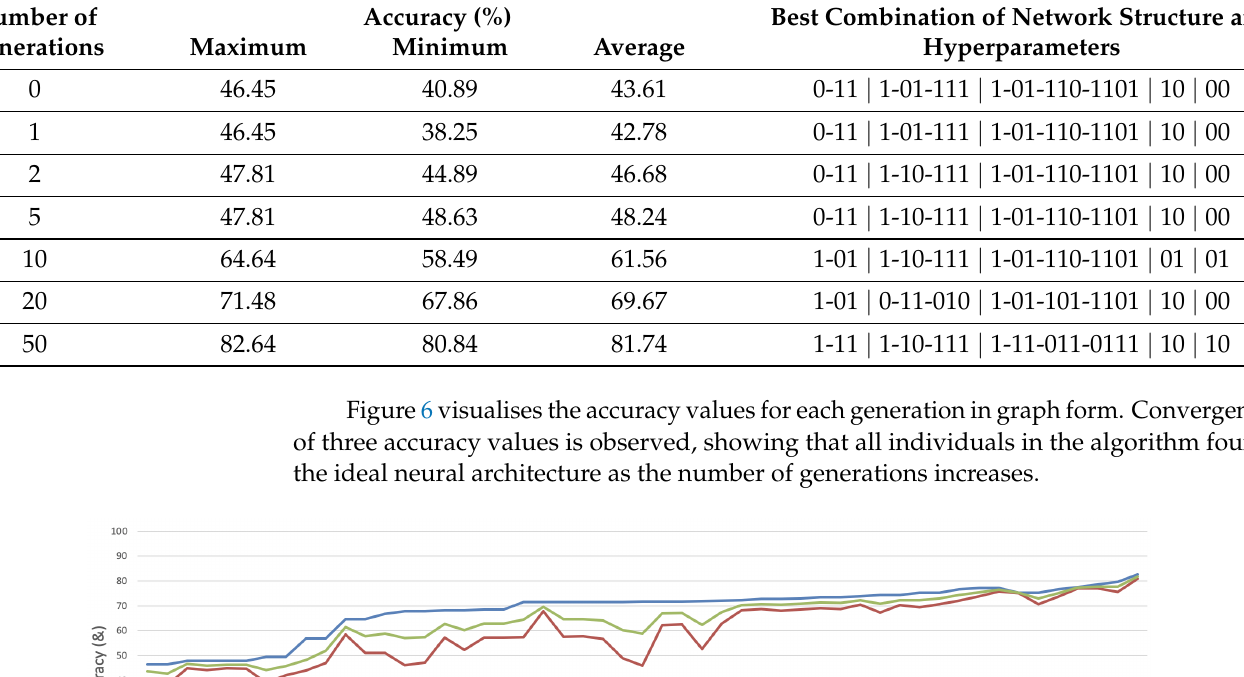
Table 3. Results of the genetic algorithm, showing accuracy of generated networks.